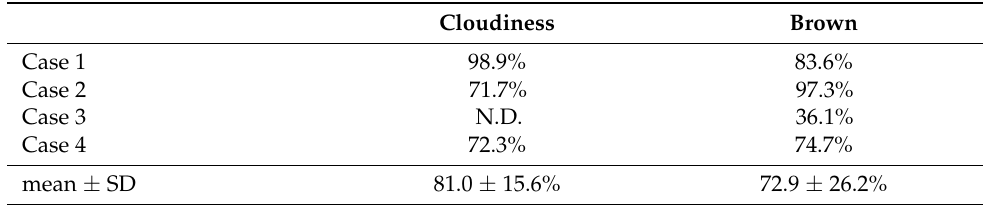
Table 6. Hyperesthesia suppressing treatment were performed once monthly. The mean and standard deviations of the improvement rate of cloudiness and brown hypomineralization were calculated (mean ± SD). N.D. = not